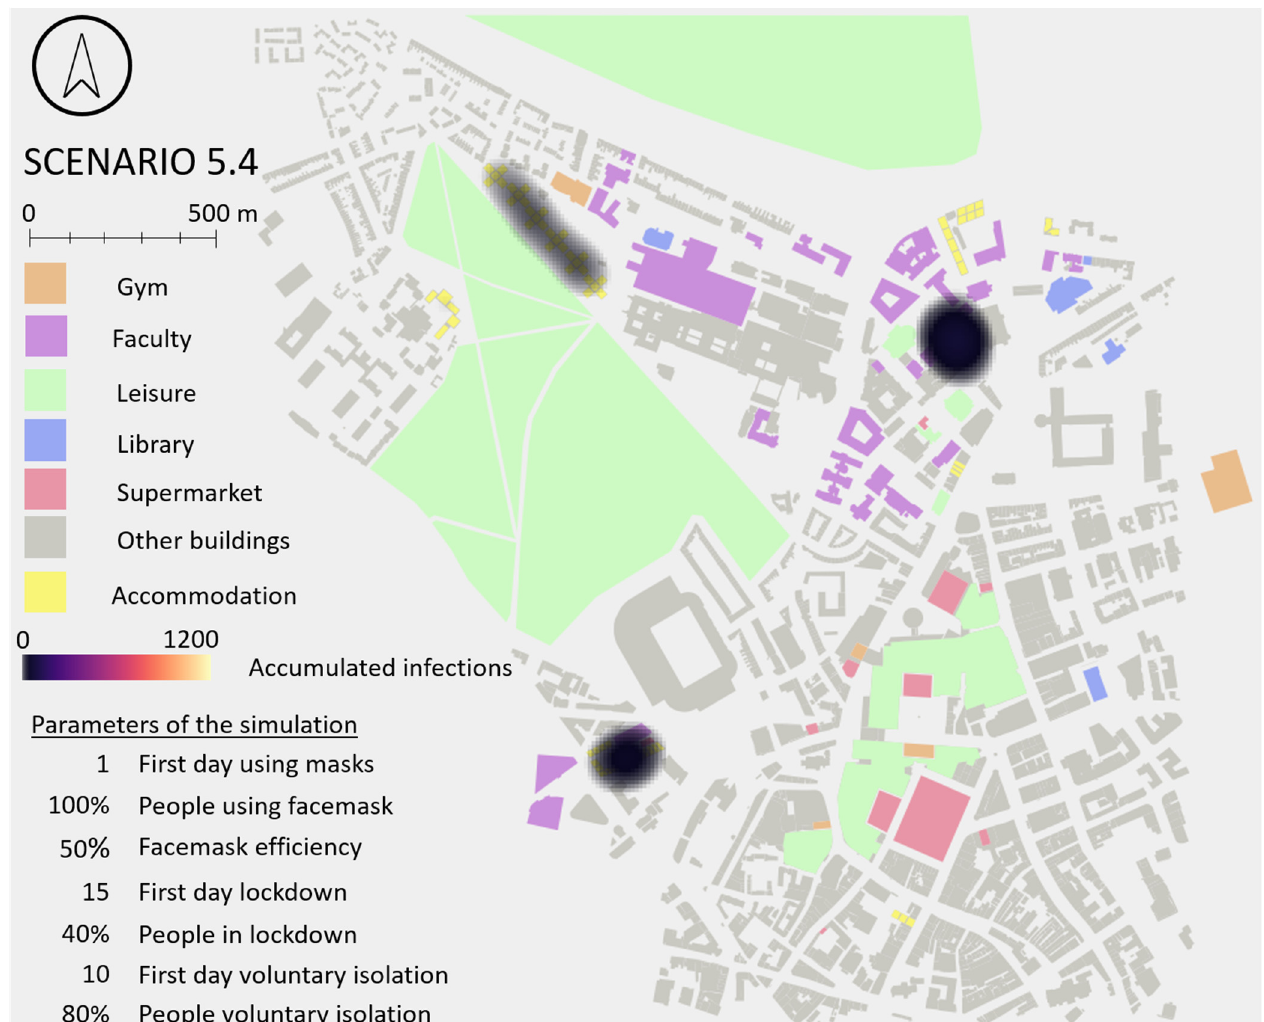
Figure A9. Heat map for Scenario 5.4 (100% students using facemask from Day 10; 60% of students in lockdown from Day 10; and 80% of Students self-isolated from Day 10) showing the areas (in light yellow) where more infections were produced. Very little and compacted areas of infection are observed (mainly in the two areas highlighted in Scenario 1). This scenario showed that 95% of Students remained Susceptible at the end of the simulation. © Crown copyright and database right 2020.